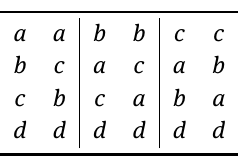
Table 8: Induced